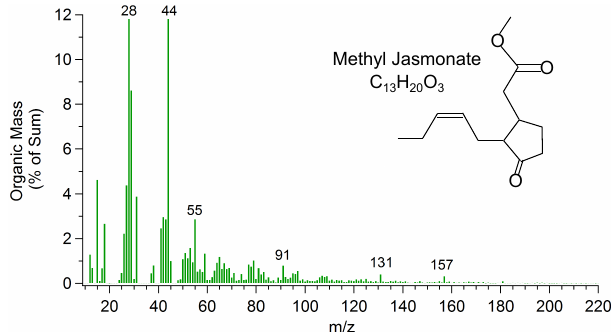
Figure 4. Normalized mass spectra of SOA generated from the oxi- dation of a MeJA standard. The x axis shows the m/z value and the y axis denotes the percent contribution of each m/z to the total or- ganic mass. The chemical structure and molecular formula of MeJA is shown on the